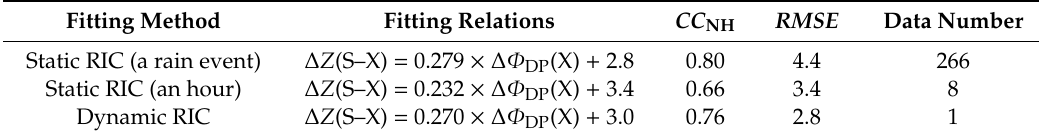
Figure 3. Frequency plots of observed S band – X band of reflectivity vs. X band differential phase after correcting Φ DP (0): ( a ) example of static RIC (a rain event) using data on the entire rainfall event of 20 July 2016; ( b ) example of static RIC (an hour) using data from 05:48 to 06:48 Beijing time; ( c ) example of dynamic RIC using data before the 06:16 Beijing time. The black dotted line in ( a – c ) are the optimal regression lines. Table 3. Estimated coefficients in Δ Z (S – X) = a × ΔΦ DP (X) + Δ Z 0 relations by static or dynamic RIC.